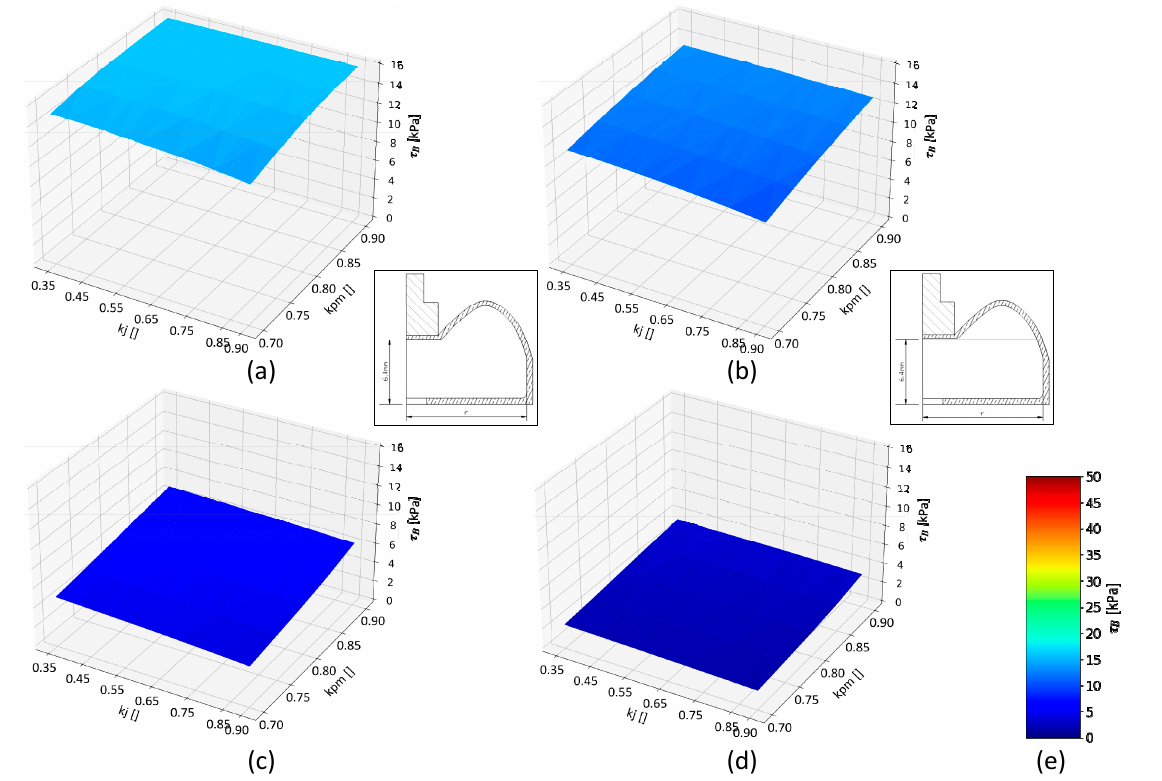
Figure 15. Average values of τ B shear stress along the measurement section of the MR cushion section of the Instance 3 variant for all configurations kpm / kj . Analysis was performed for the value gm = 6 mm and the distance of the magnetic field exciter z equal to: ( a ) 0; ( b ) 1; ( c ) 5; ( d ) 10 mm; ( e ) color scale indicating shear stress value.